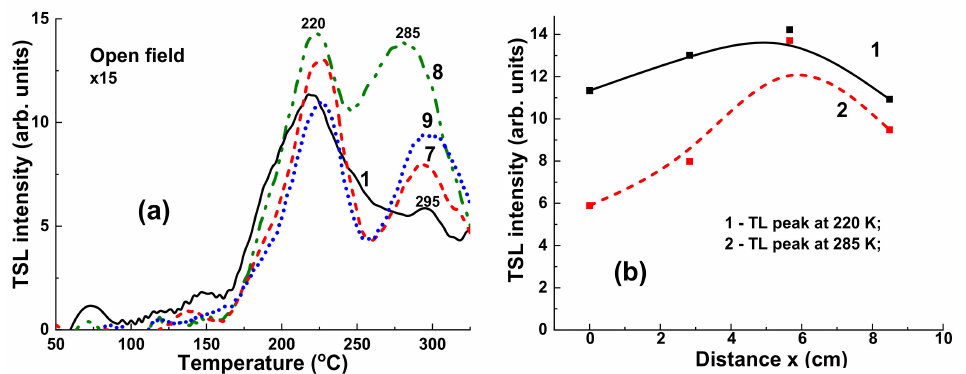
Figure 13. ( a ) TSL glow curves for YAG:Ce crystal detector irradiated by 15 MV X-ray photons from a Clinac 2300 accelerator in open field mode; ( b ) dependence of the intensity of two TSL peaks of YAG:Ce crystal at 220 ◦ C (1) and 285 ◦ C (2) on the distance x between sample and centers of